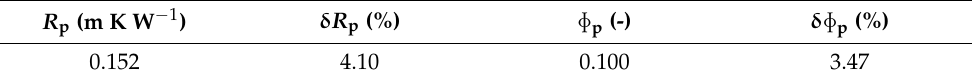
Table 6. OTRT parameters inferred from the field test and related uncertainties δ